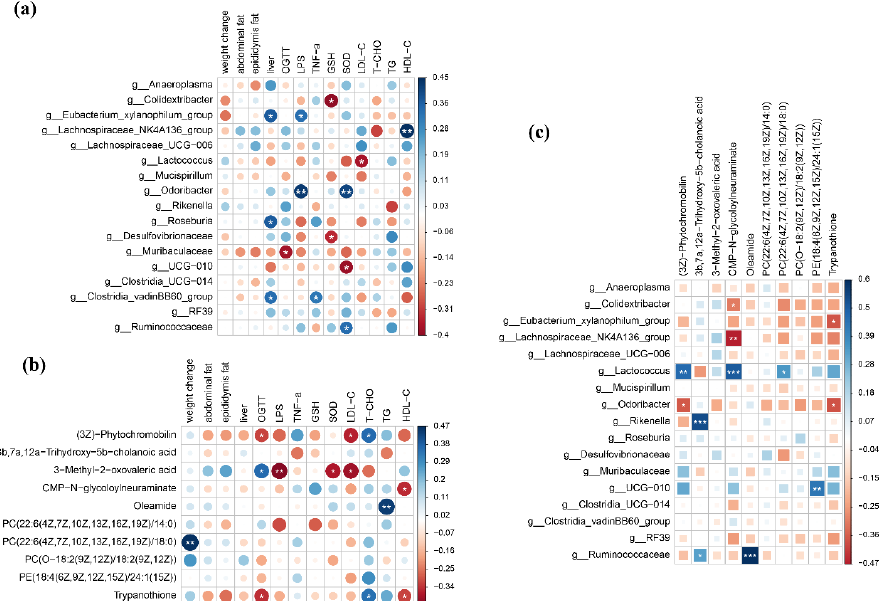
Figure 5. Association of clinical phenotypes with gut microbiota and serum metabolites from a systems biology perspective. Correlation heatmap showing the functional relationship between the clinical index and disturbed gut bacterial genera ( a ). Correlation heatmap showing the functional relationship between the clinical index and altered serum metabolites ( b ). Correlation heatmap between the altered gut microbiome and metabolites ( c ). Blue represents positive associations. Red denotes inverse associations. Heatmap differences were analyzed using an R package (* p < 0.05, ** p < 0.01).